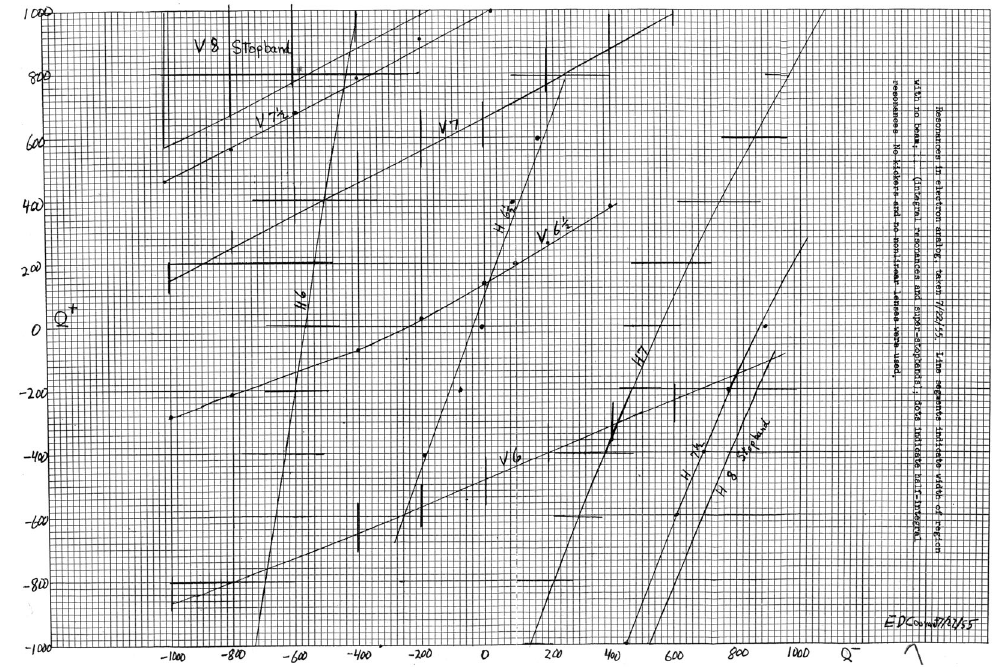
FIG. 2. Tune plane resonance diagram measured during machine studies at the AGS analog ring and reported by Courant [6]. A more polished and complete version of this plot, copied from Plotkin [5], is shown in Fig. 13 but with minor relabelings. This was published with permission of Brookhaven National